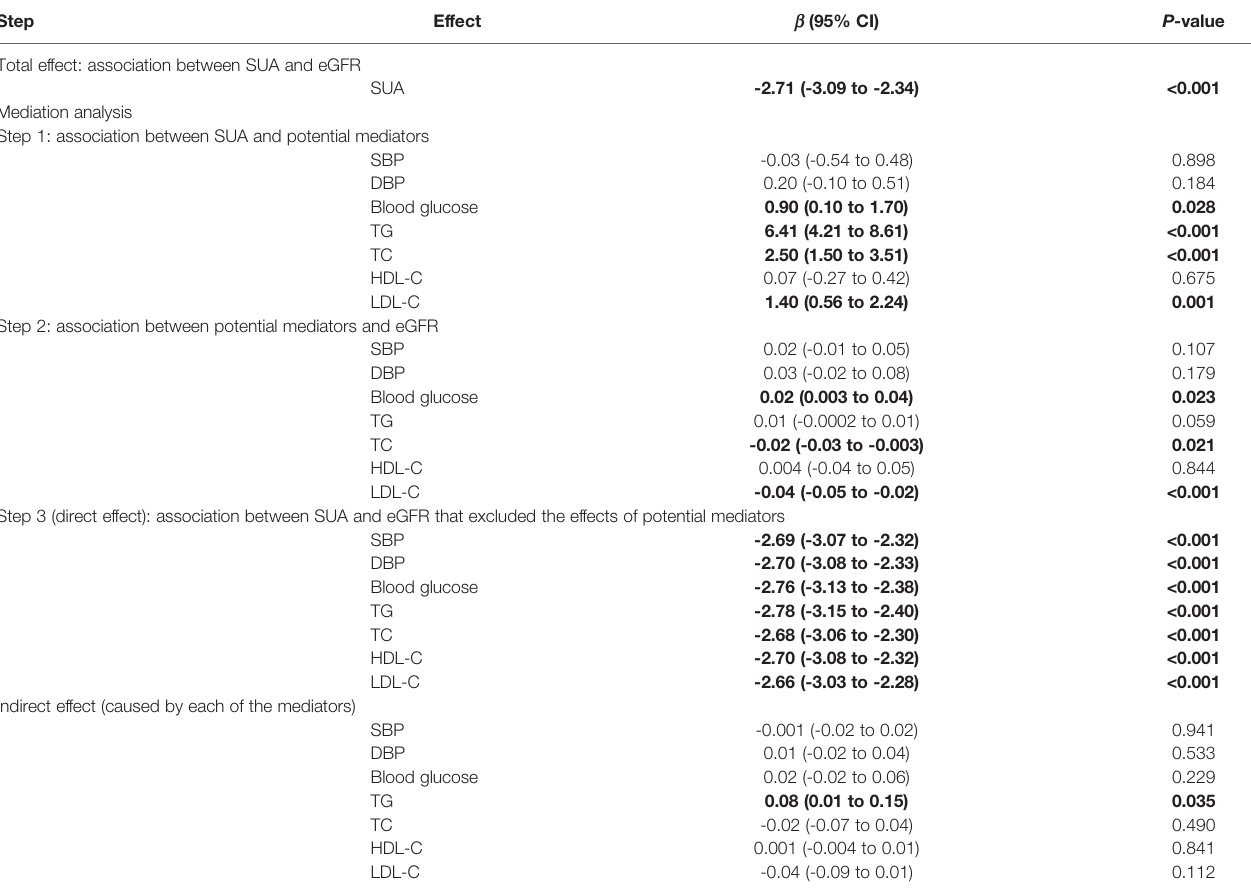
TABLE 3 | The mediating effects of cardiometabolic factors on the association between SUA and eGFR in